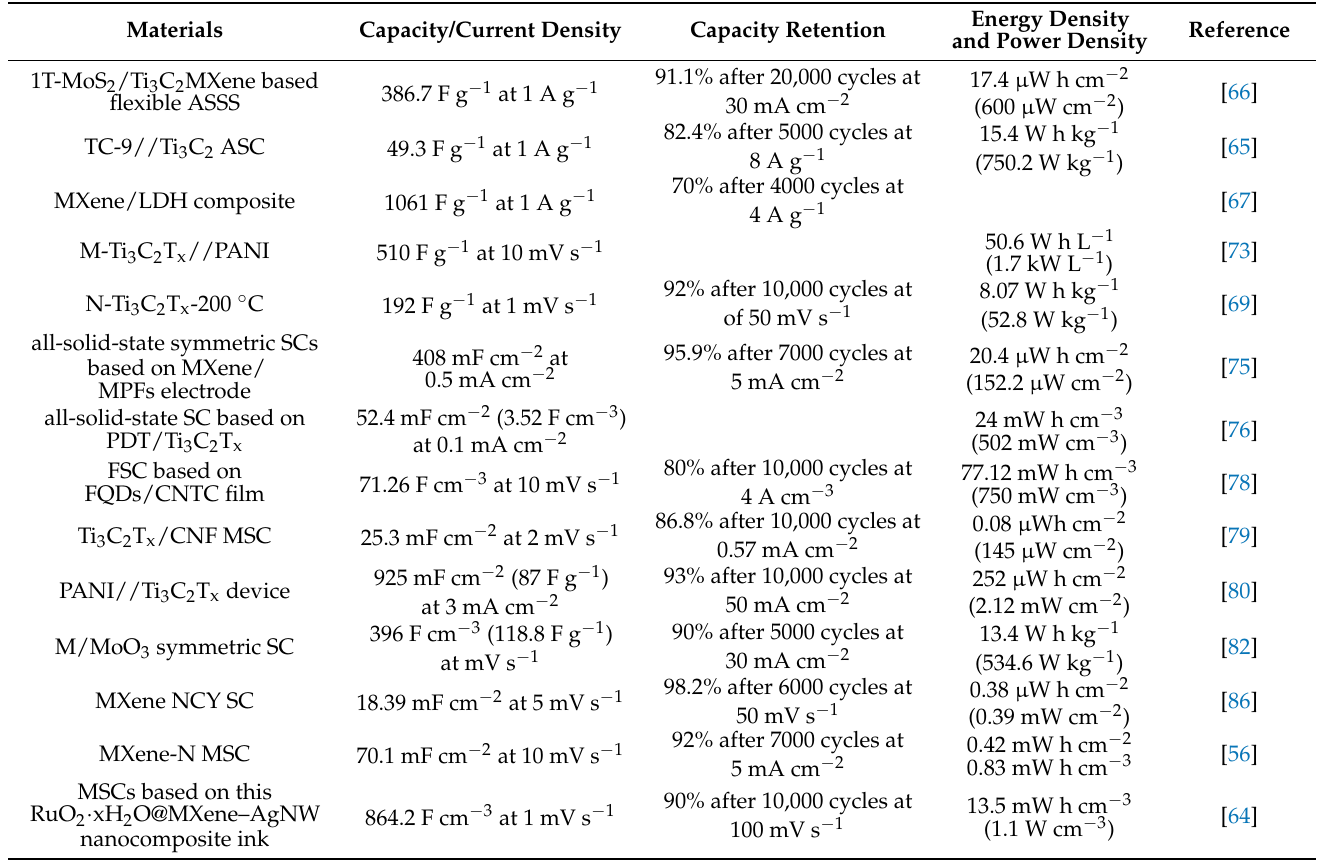
Table 1. Comparison of the electrochemical properties of different MXene-based materials for